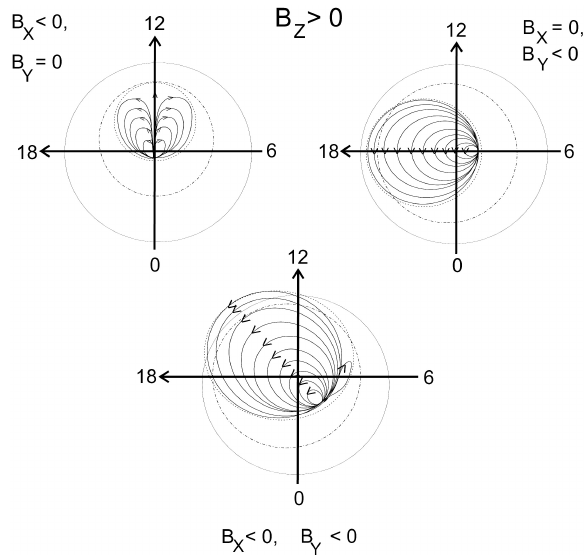
Fig. 4. Distribution of the electric equipotentials in the open field line region of the northern polar cap in the spherical model for northward IMF dependent on b x and b y .